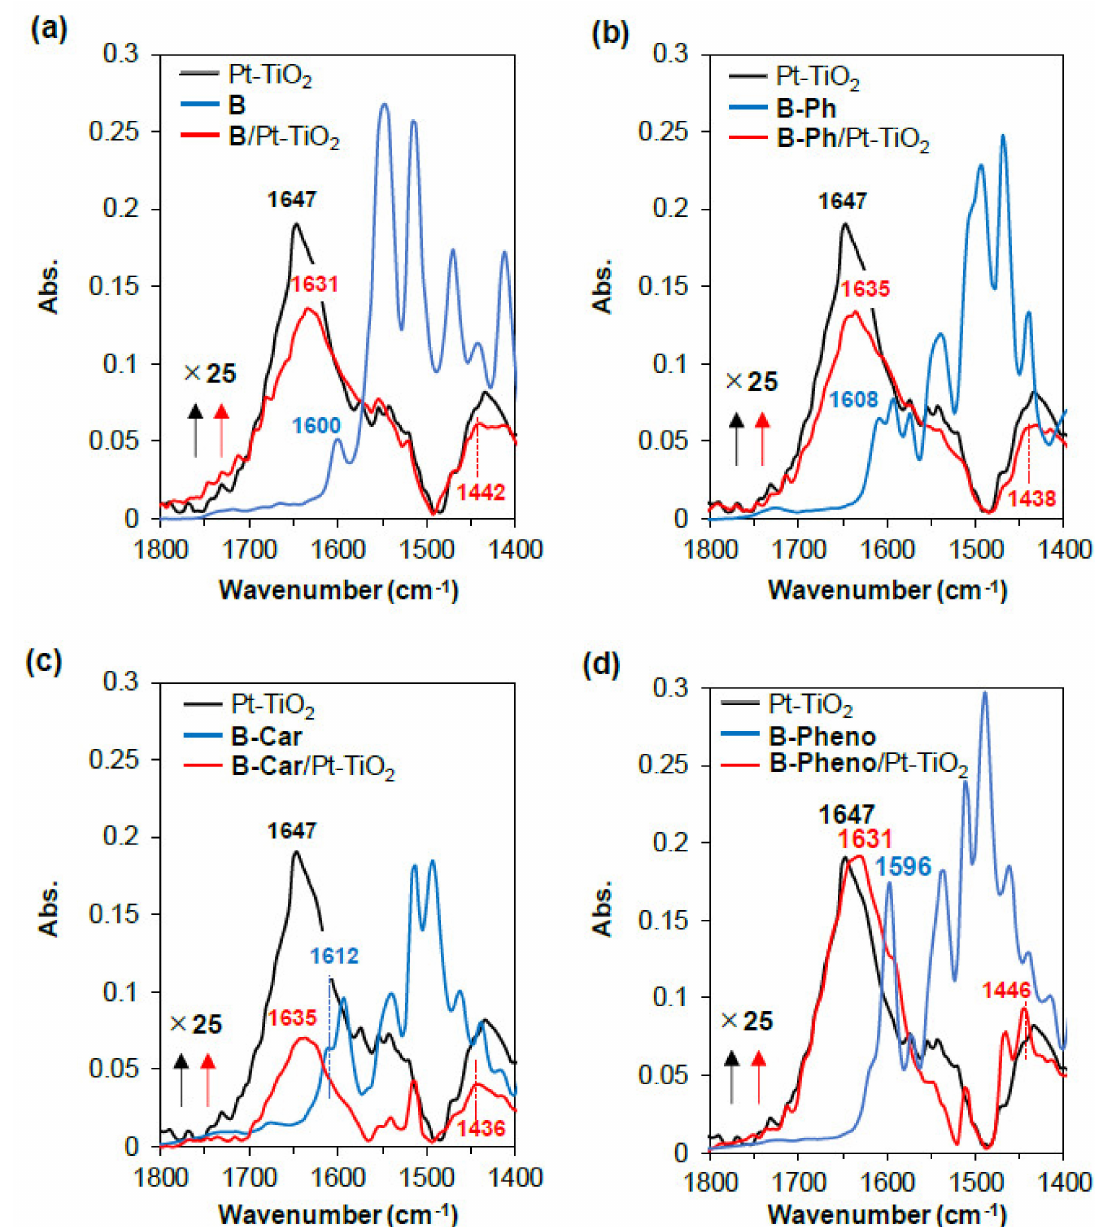
Figure 5. IR spectra of ( a ) B and B / Pt-TiO 2 ; ( b ) B-Ph and B-Ph / Pt-TiO 2 ; ( c ) B-Car and B-Car / Pt-TiO 2 ; and ( d ) B-Pheno and B-Pheno / Pt-TiO 2